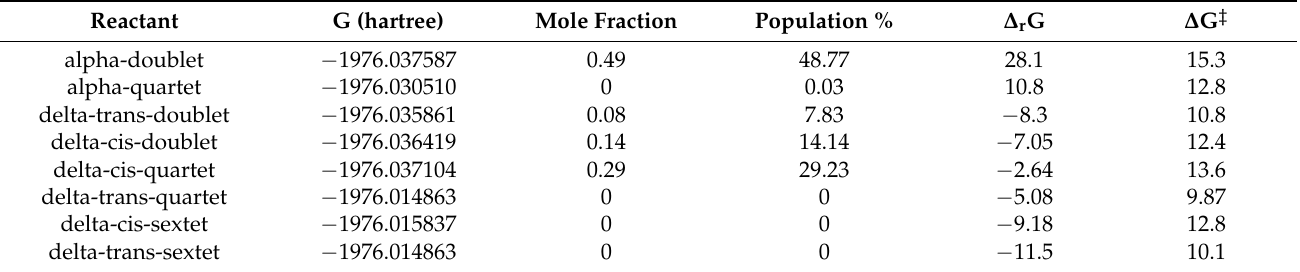
Table 5. Boltzmann distribution for conformers present in reaction coordinate I for the β -pinene.